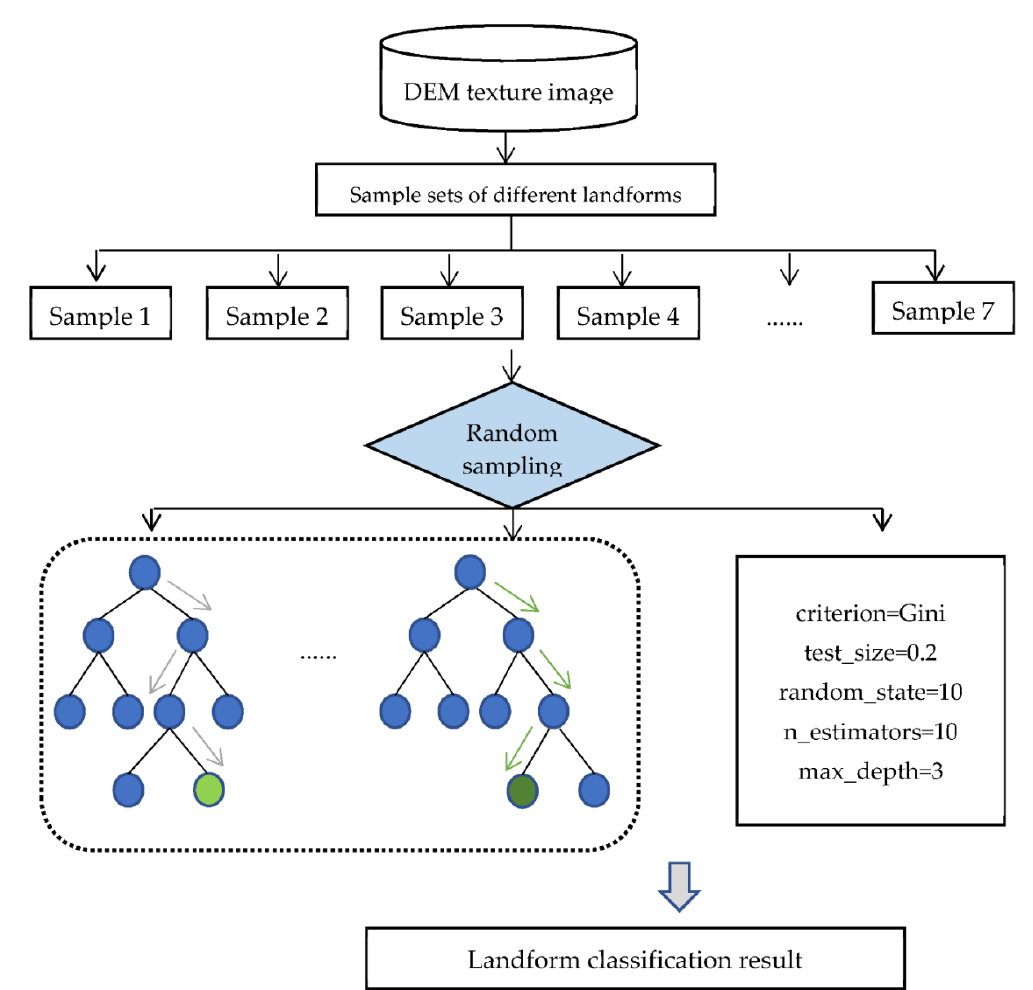
Figure 8. Classification process of landform types based on the RF method.